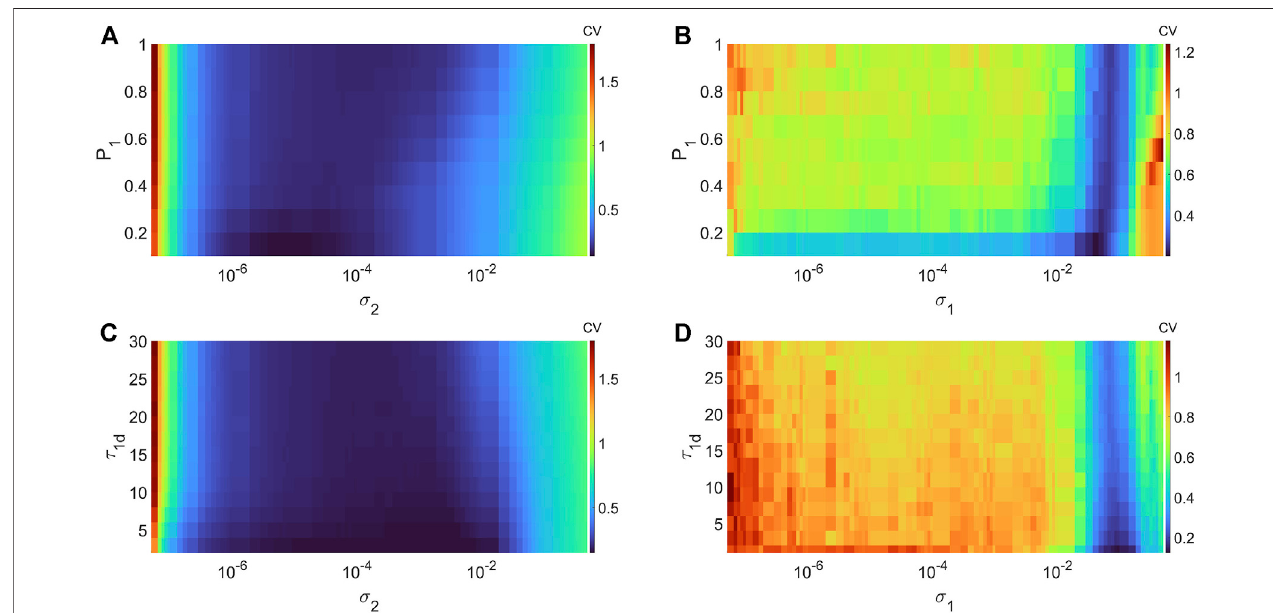
FIGURE 5 | Variation of CV w.r.t. the potentiation adjusting rate P 1 , depression temporal window τ 1 d , and the noise intensity σ 1 or σ 2 , with the corresponding non- optimal networkparametervalues.Panel (A) and (B) showthevaluesofCVduringCR( σ 1 =0, ε 1 =0.01, 〈 s 1 〉 =10, β =1, τ 1 =100, τ 1 d =20)andduringSISR( σ 2 =0, ε 1 = 0.001, 〈 s 1 〉 =1, β =0.1 τ 1 =600, τ 1 d =20).Panel (C) and (D) showthevaluesCVduringCR( σ 1 =0, ε 1 =0.01, 〈 s 1 〉 =10, β =1, τ 1 =100, P 1 =1)and during SISR ( σ 2 = 0,